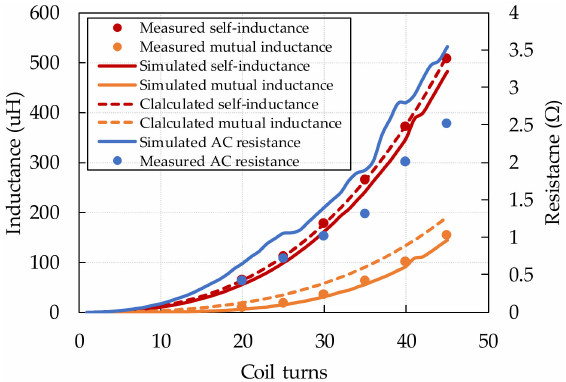
Figure 7. Relationship between coil turns and coil-system parameters with fixed inner radius.